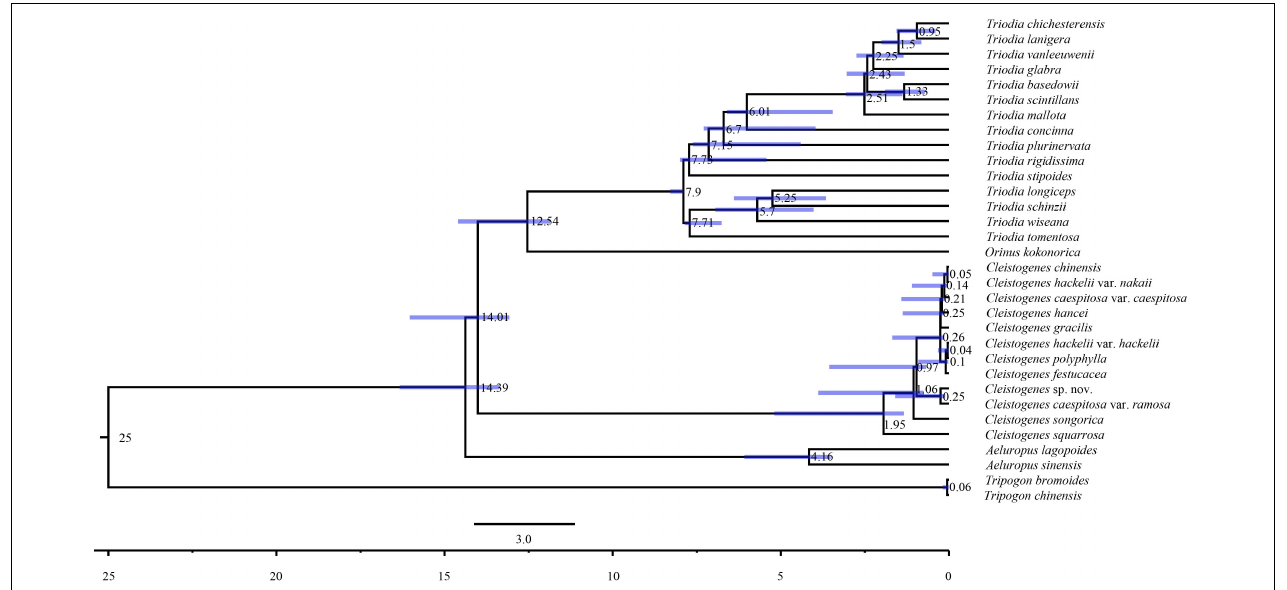
FIGURE 7 | Chronogram of 32 taxa based on complete plastomes inferred by using treePL. Blue bars represent the minimum and maximum estimation of node ages.